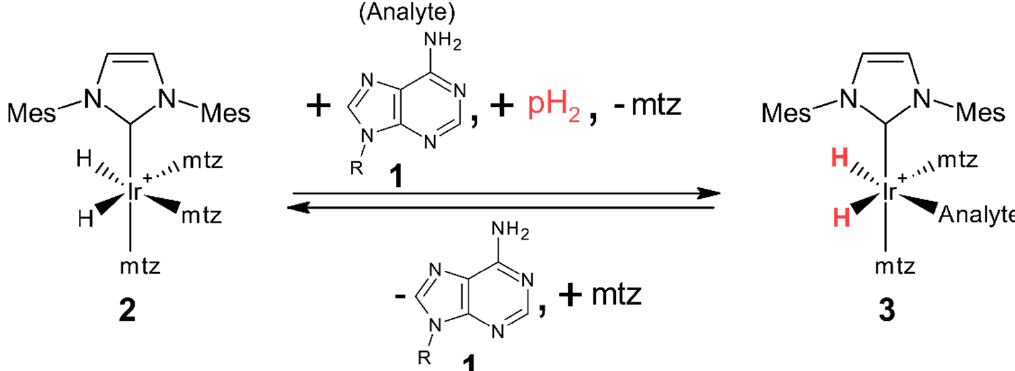
Figure 1. The principle of chemosensing by p H 2 -induced hyperpolarization [4]. Complexes 3 are transient in nature, which is necessary for the incorporation of a new analyte and fresh p H 2 . Mes denotes 1,3,5-trimethylphenyl group, known as mesityl group; mtz denotes 1-methyl-1,2,3-triazol.